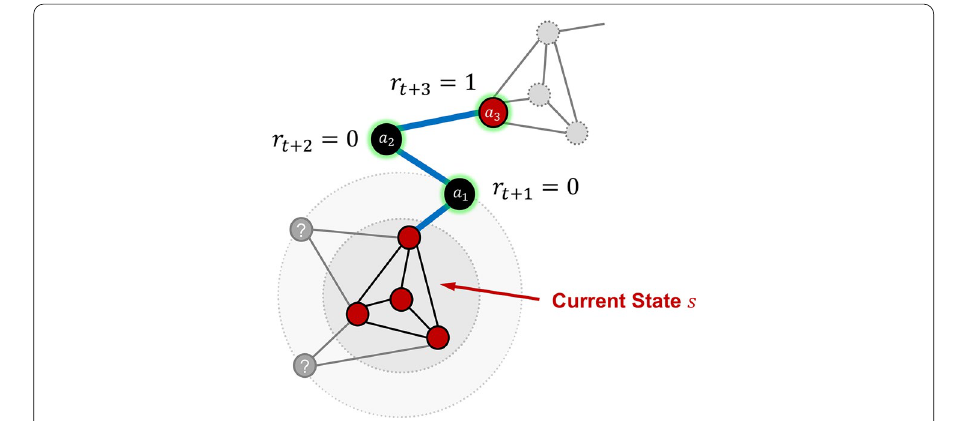
Fig. 1 Illustration of estimation of cumulative reward of current state s = s 0 over a horizon of length h = 3 , and discount factor γ = 0.5 . The current state s is comprised of 3 types of nodes: unknown (grey), target‑nodes (red), non‑target nodes (black); red nodes represent the node type we would like to discover. The figure shows an instantiation of policy π , starting at state s , corresponding to a path of length h = 3 . We calculate the cumulative discounted reward of state s based on taking action a 1 at t = 0 and following the highlighted path as follows: Q ( s , a 1 ) = γ t ∗ r t + 1 + γ t + 1 ∗ r t + 2 + γ t + 2 ∗ r t + 3 = 1 ∗ 0 + 1 / 2 ∗ 0 + 1 / 4 ∗ 1 = 1 / 4